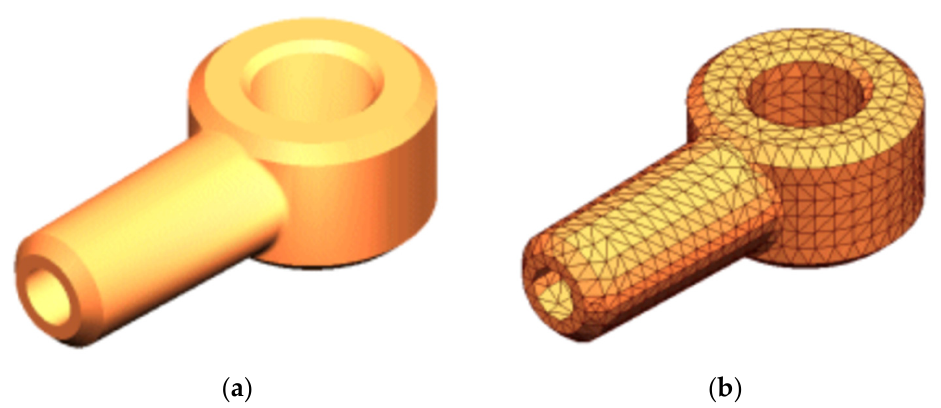
Figure 2. An example of finite element method ( a ) CAD model of a part ( b ). Model subdivided into small pieces (elements).